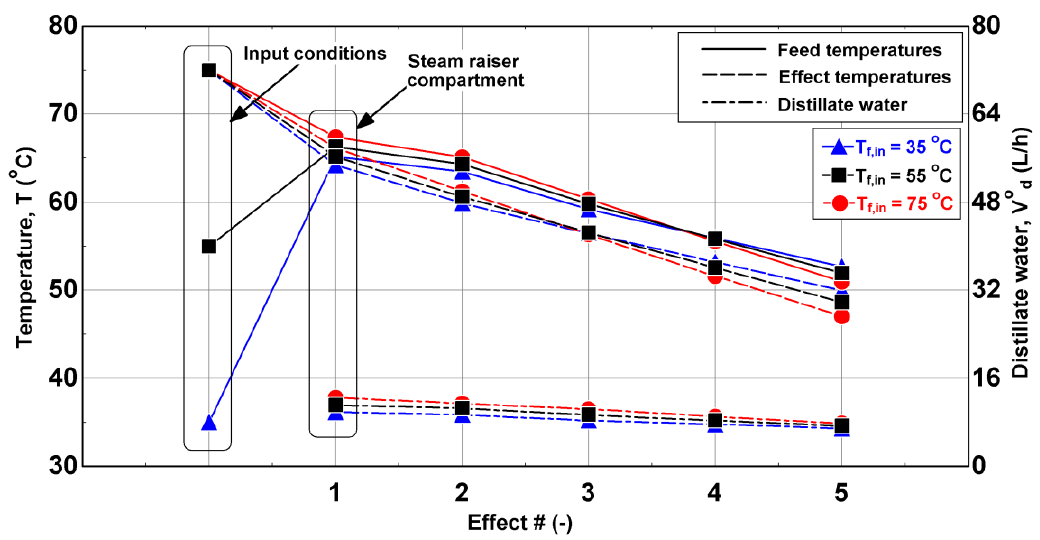
Figure 8. Numerical results of feed water temperatures, effect temperatures and distillate water throughout effects for different feed water temperatures (T c,in = 25 °C).